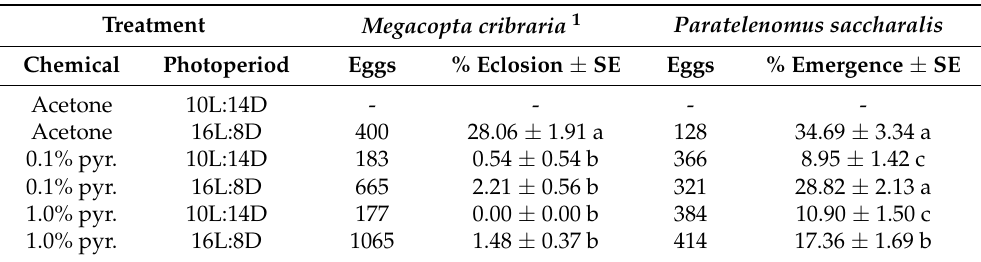
Table 3. Percentage of Megacopta cribraria eclosion and P. saccharalis emergence by treatment group from the September collection.